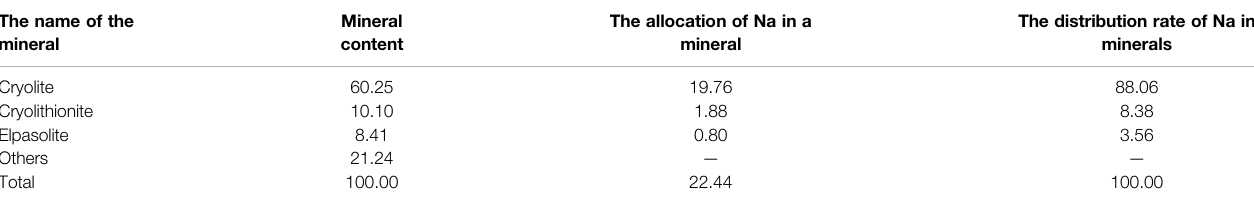
TABLE 6 | Calculation table of sodium distribution rate in sodium-containing minerals/%. The name of the mineral